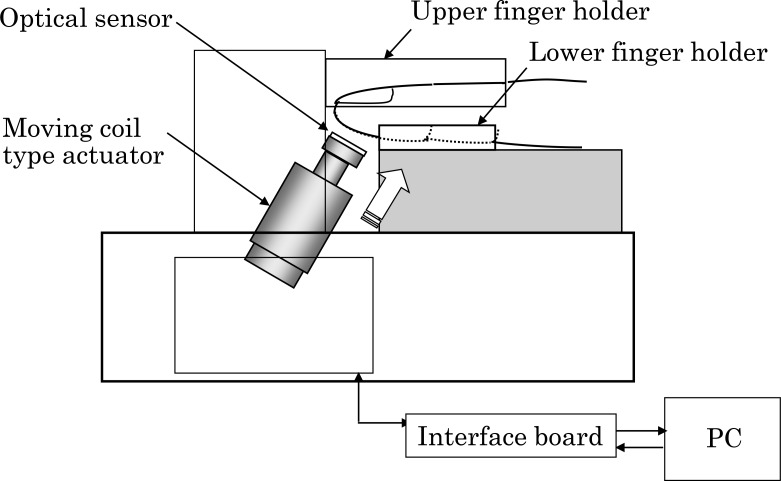
Cross-sectional image of the optical sensor with a pressurization mechanism.